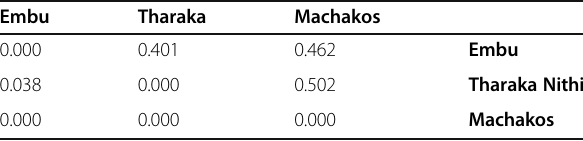
Table 7 Pairwise comparison of the three mung beans populations based on the Fst